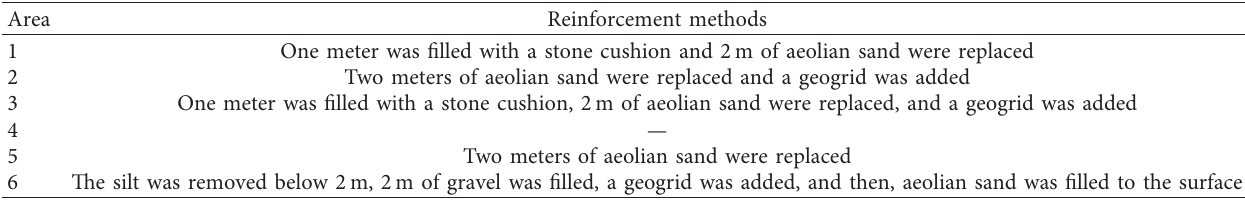
Table 4: Reinforcement methods for each area.